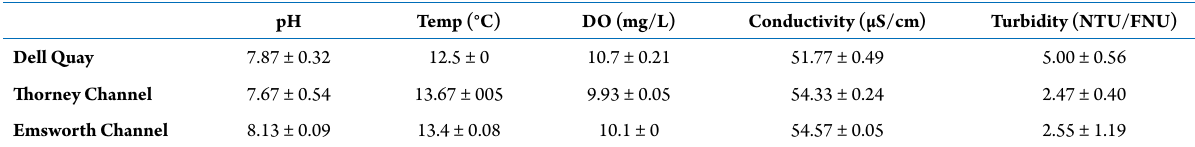
Table 1. Water quality parameters collected prior to each trawl at each sampling location in Chichester Harbour showing Mean ± Standard Deviation.